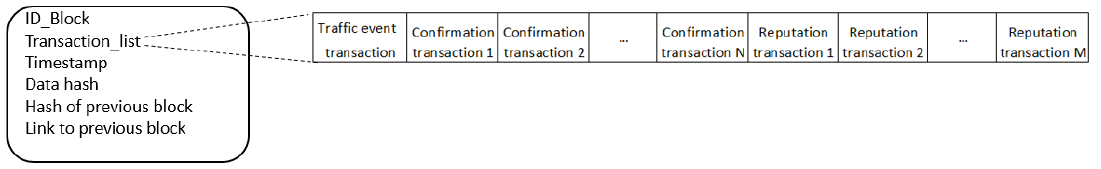
Figure 9. Example of the transactions list within a